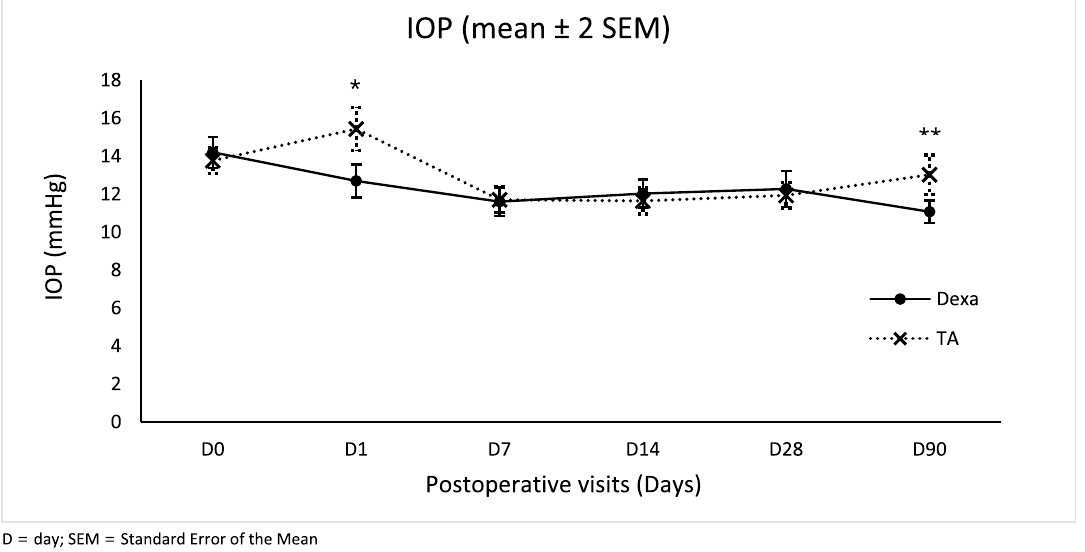
Figure 5. Mean IOP (mmHg) ± 2 SEM at each study visit. Mean IOP in Dexa group was significantly lower than in TA group on POD1 (mean difference −2.74, 95% CI −4.15, −1.34; * p < 0.001) and post operative day 90 (mean difference −1.95, 95% CI, −3.15, −0.76; ** p = 0.002). Whereas, there was no significant difference in mean IOP between treatment arms in the other